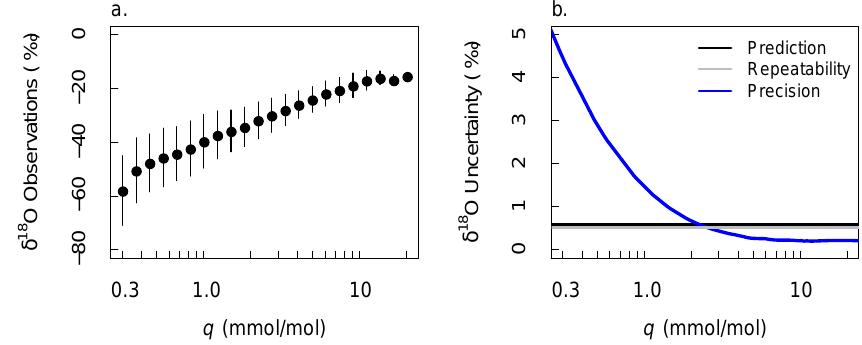
Figure 8. (a) The calibrated Mauna Loa δ 18 O ambient data averaged as a function of the water vapor volume mixing ratio ( q ), with 1 σ deviations given by vertical lines. (b) Sources of uncertainty in the δ 18 O ambient data include the prediction errors from correcting the total isotopic bias with a locally weighted polynomial regression (black), measurement repeatability errors (gray), which are estimated from the root mean square error associated with fitting a linear regression to the corrected calibration data, and instrument precision (blue), estimated from the standard deviations of the autosampler